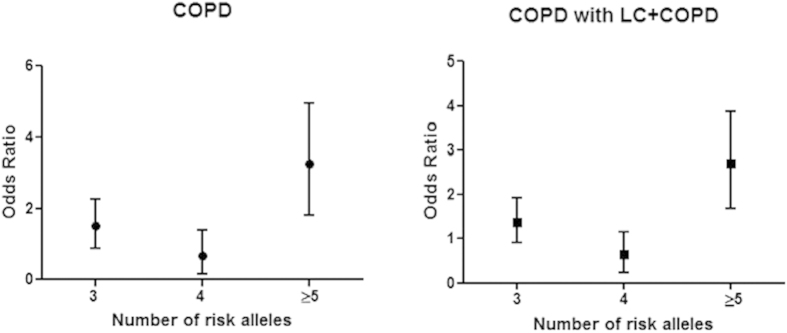
Cumulative genetic risk score (CGRS) analysis of FAM13A SNPs.The effect of unweighted cumulative genetic risk score on COPD and COPD with LC+COPD was calculated using logistic regression analysis. The odds ratios (black symbols) with 95% confidence intervals (range bars) for the number of risk alleles at each of FAM13A SNPs are represented from unweigheted analysis. COPD: chronic obstructive pulmonary disease; LC: lung cancer; COPD with LC+COPD: COPD with 40% admixture of subjects with concomitant LC.